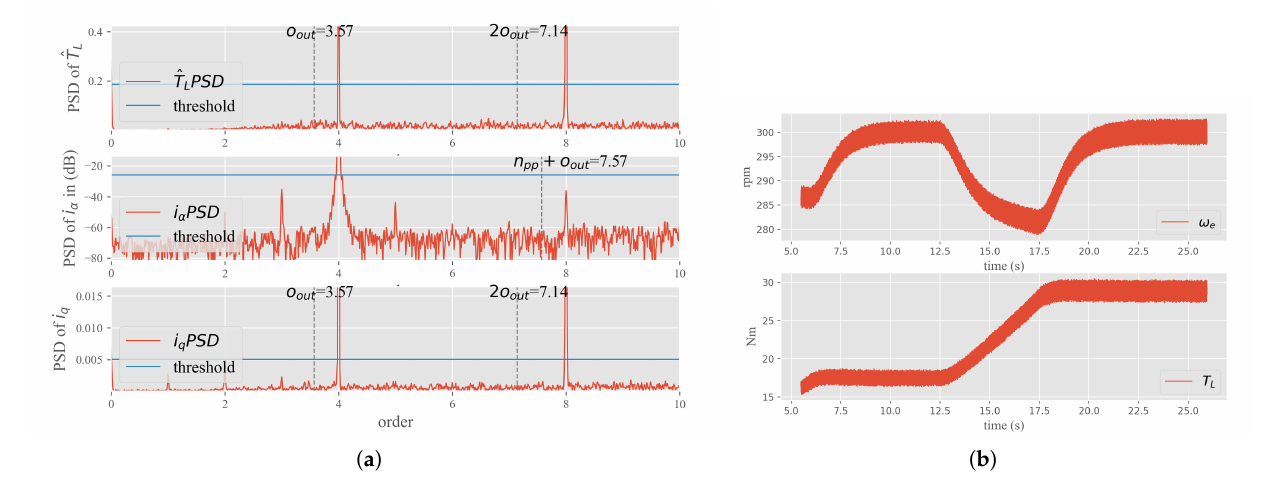
Figure 7. Torque varying experiment of the healthy motor ( a ) power spectrum density and ( b ) graph- ical transients of speed and torque.